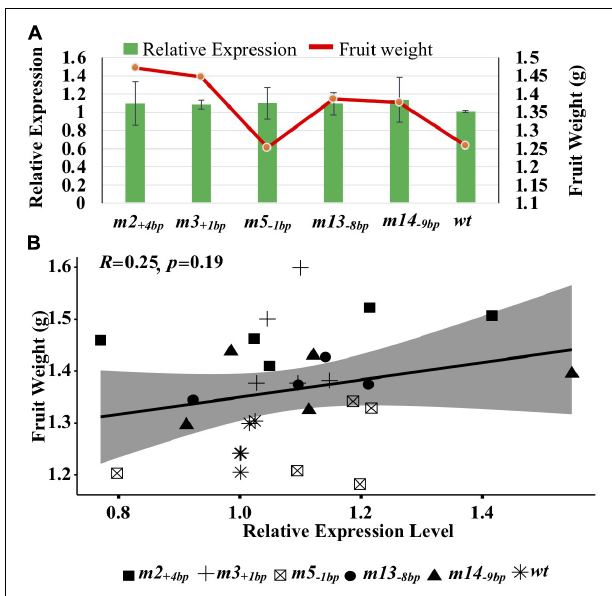
FIGURE 5 | Non-linear relationships between transcriptional change for SlKLUH and fruit weight variation. (A) SlKLUH expression and fruit weight analyses of the m2 + 4 bp , m3 + 1 bp , m5 − 1 bp , m13 − 8 bp , and m14 − 9 bp homozygotes; (B) The correlation between SlKLUH expression and fruit weight. Each point represents one plant per genotype. Two experimental evaluations were taken, each with four to five plants per genotype. The m13 − 8 bp and m14 − 9 bp homozygotes were only included in one experimental